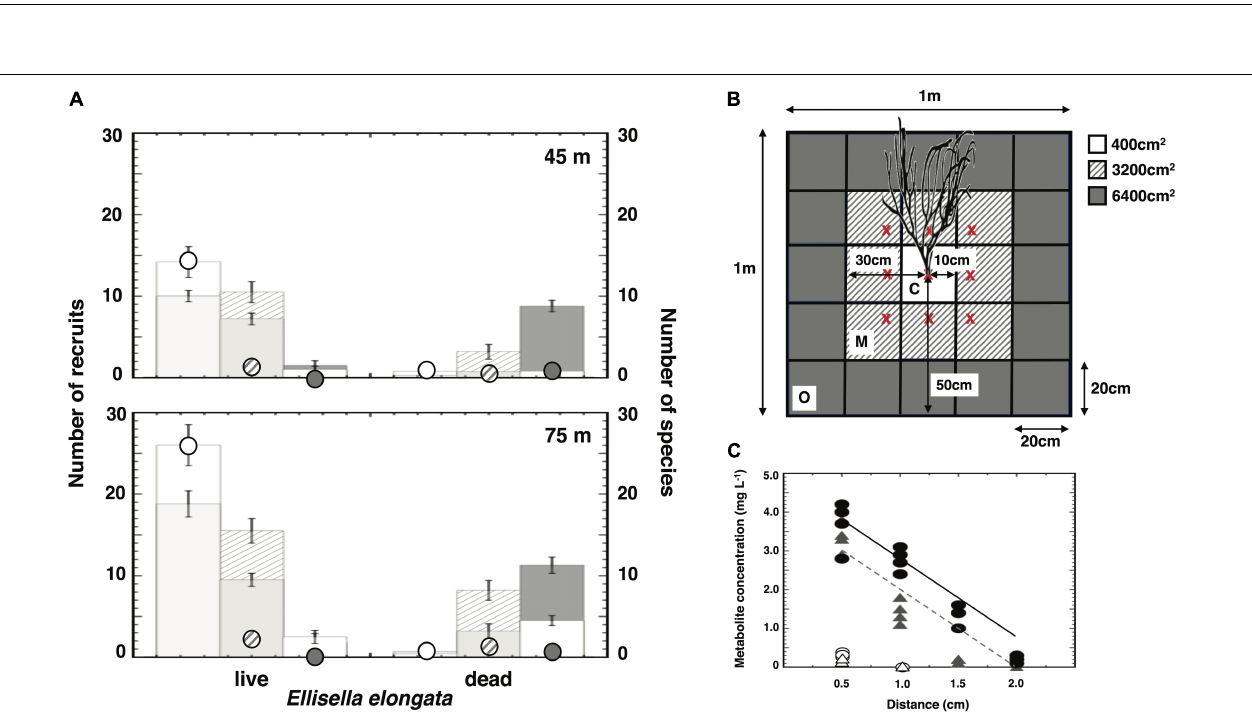
FIGURE 4 | Recruitment in the presence of live or dead gorgonians. Histograms represent the mean ± SE. (A) Recruit numbers per m 2 (raw: bars) and relative to area surrounding gorgonian (scaled: circles) at depths of 45 and 75 m. The number of species are represented by the shorter bars within each histogram (i.e., fewer species than number of recruits). (B) Schematic representing all 20 × 20 cm plots within 1 m 2 relative to the central gorgonian (live or dead) (c = center: all recruits within 10 cm of gorgonian base; m = middle: all recruits within 10–30 cm of gorgonian base; o = outer: all recruits within 30–50 cm of gorgonian base). Note: x’s represent approximate locations of each gorgonian in the 3 × 3 PVC array. (C) Metabolite (7:3 mixture of junceelloside C: compound 2) concentration with increasing distance from surface of Ellisella elongata . Symbols represent the mean ± SE mg of mixture per liter of seawater extracted (gray triangles: 45 m, black circles: 75 m). Approximately six additional “compounds” were apparent on HPLC chromatograms at baseline concentrations (white triangles and circles) that could not be identified.